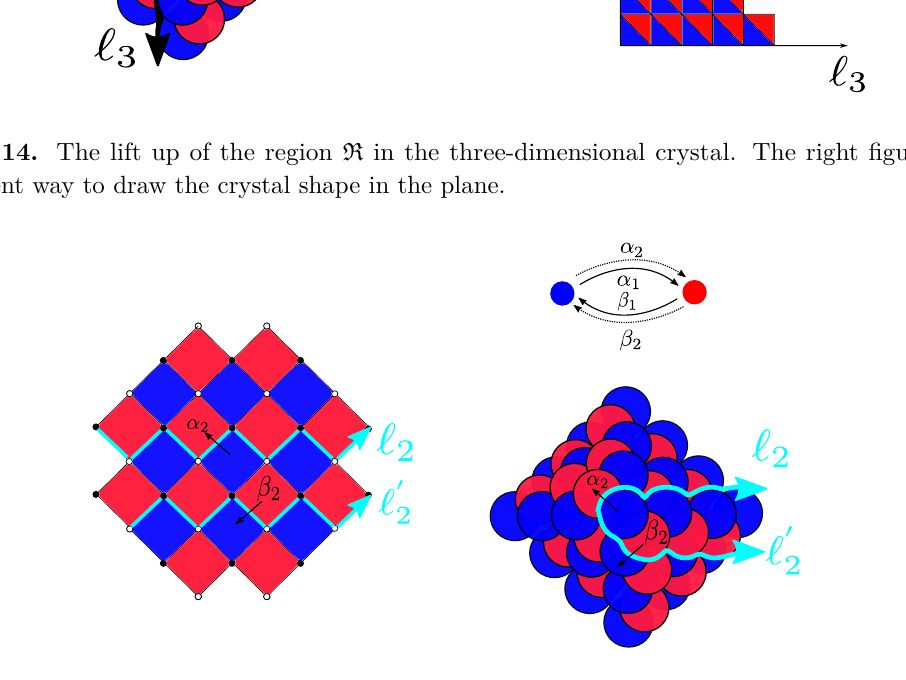
Figure 15. The region surrounded by the two external legs ‘ 2 and ‘ 0 external leg as ‘ in the toric diagram but different in the universal covering. The subquiver is 2 obtained by removing m = { α because the external leg ‘ 2 ∪ m 4 2 , β 2 } p 2 , p 4 . The uplift to the three-dimensional crystal is the right down